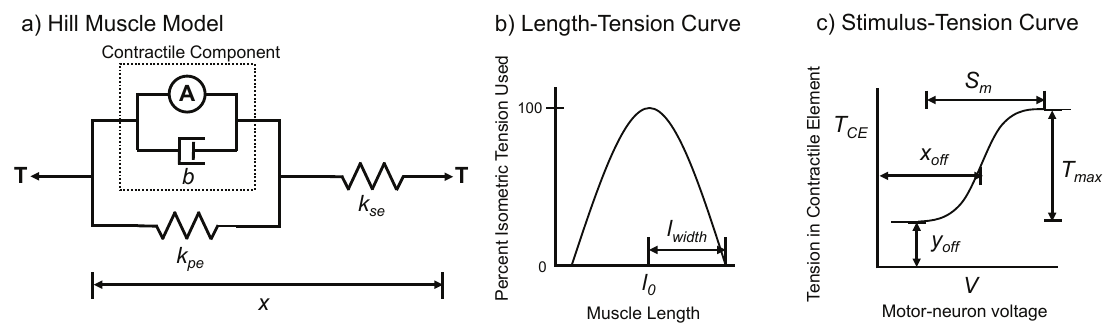
Figure 1. Hill Muscle Model used in AnimatLab 2 (adapted from [34]). ( a ) The model contains a series spring, a parallel spring, a parallel damper, and an active component; ( b ) the length-tension curve adjusts the active tension based on the length of the muscle; ( c ) the stimulus-tension curve adjusts the active tension based on the voltage of the